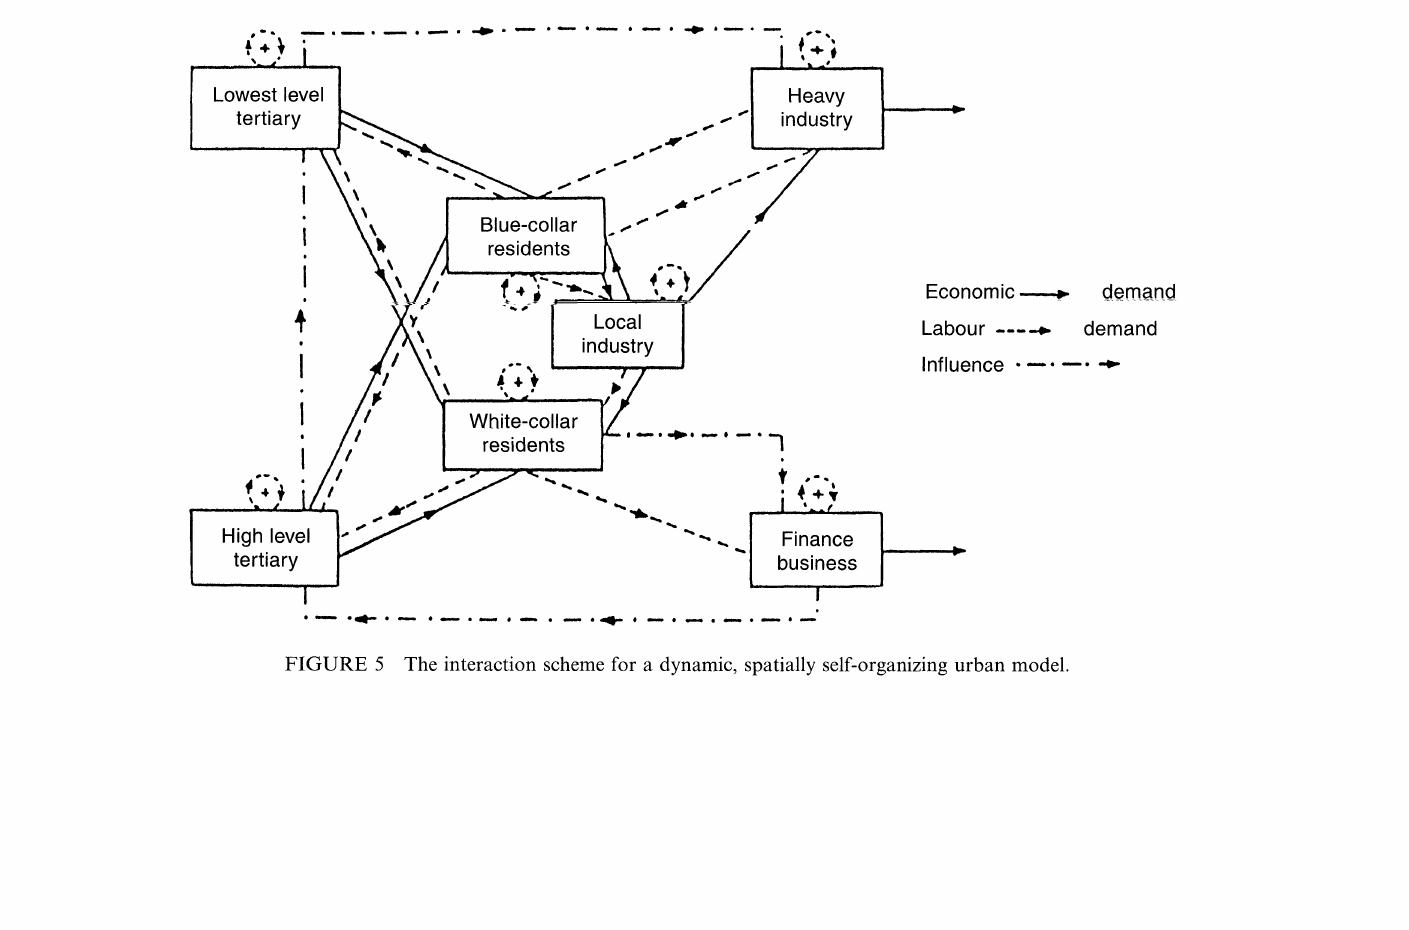
FIGURE 5 The interaction scheme for a dynamic, spatially self-organizing urban